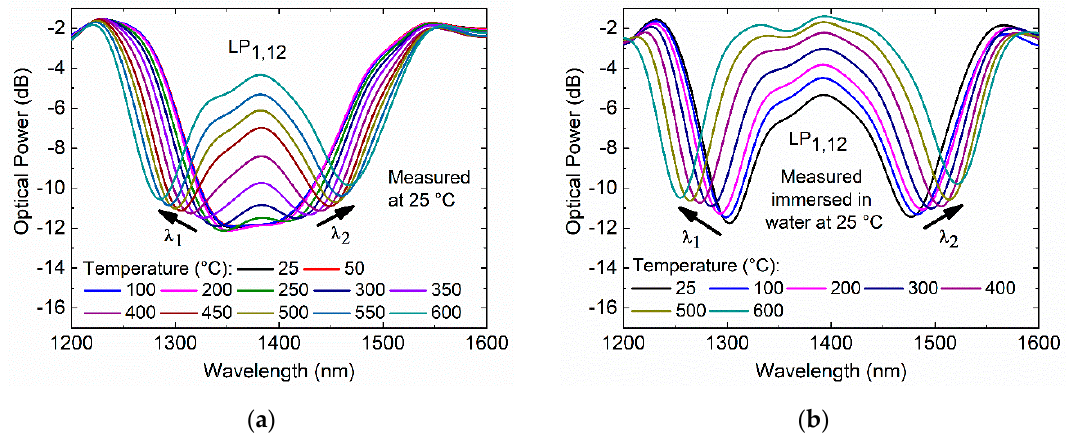
Figure 9. Fs-laser TAP LPFG inscribed with a period of 182.7 µm: ( a ) transmission spectra at room temperature; ( b ) transmission spectra immersed in water at room temperature.